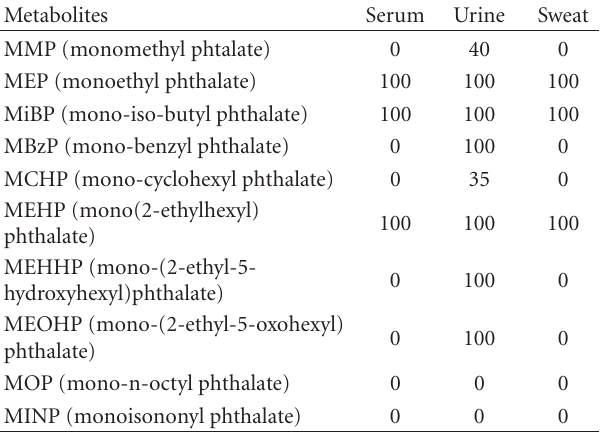
Table 5: Percentage of individuals with detection of phthalate metabolites in body